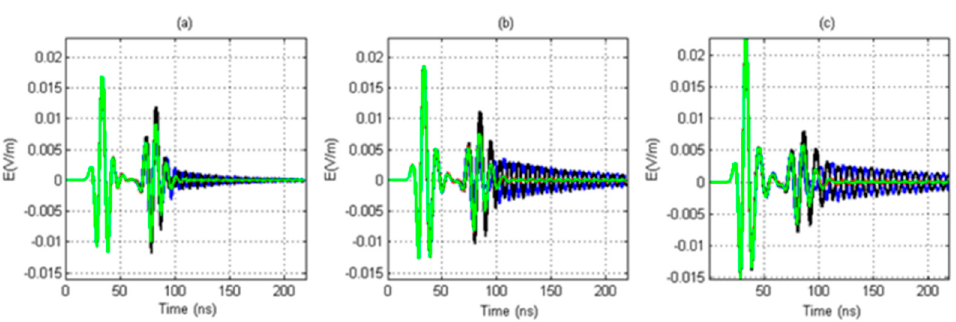
Figure 8. Received signal for the cases of in-borehole dielectric constants ( a ) 33, ( b ) 53, and ( c ) 73.